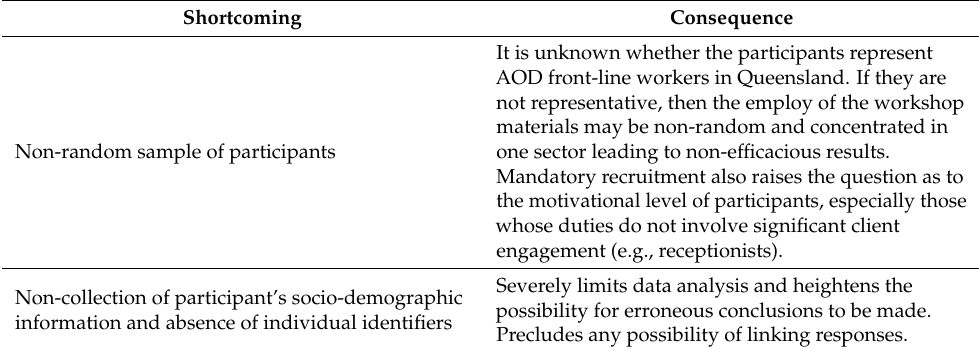
Table 1. Methodological shortcomings in the pre- and post-test design and consequences for the self-evaluation